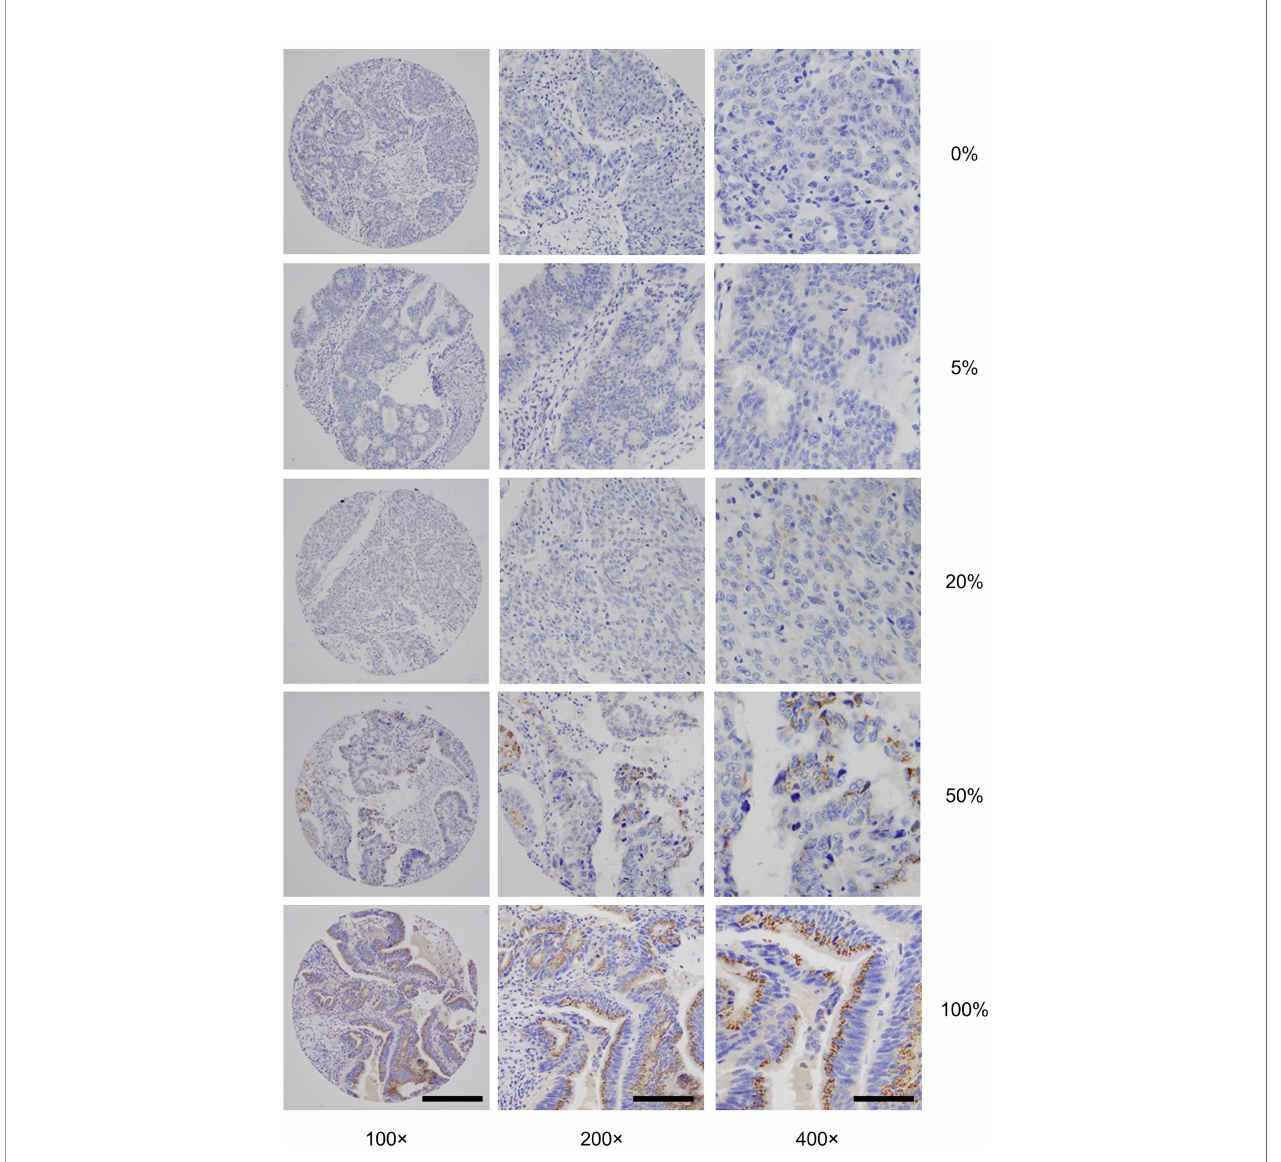
FIGURE 1 | Representative GALNT6 protein expression in fi ve different colorectal adenocarcinomas (rows from top to bottom). GALNT6 protein expression (brown) with nuclei counter-stained (blue). The representative cases shown correspond to histologically moderately (rows 1, 2, 4, and 5) or poorly (row 4) differentiated adenocarcinomas. Numbers to the right indicate the percentages of GALNT6 positive tumor cells for each case. The fi nal microscopic magni fi cation is shown at the bottom of each column. The scale bars represent, from left to right columns, 120, 60, and 30 µm,